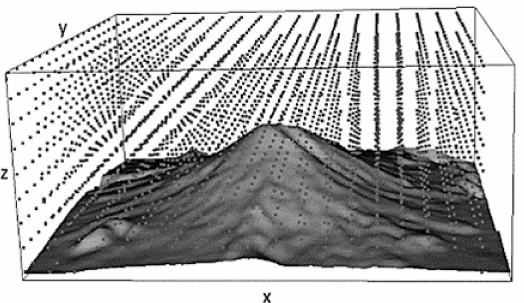
Figure 3. Diagram showing a 3D search lattice above a digital elevation model (DEM). Each dot represents the center of multiple spherical trial surfaces